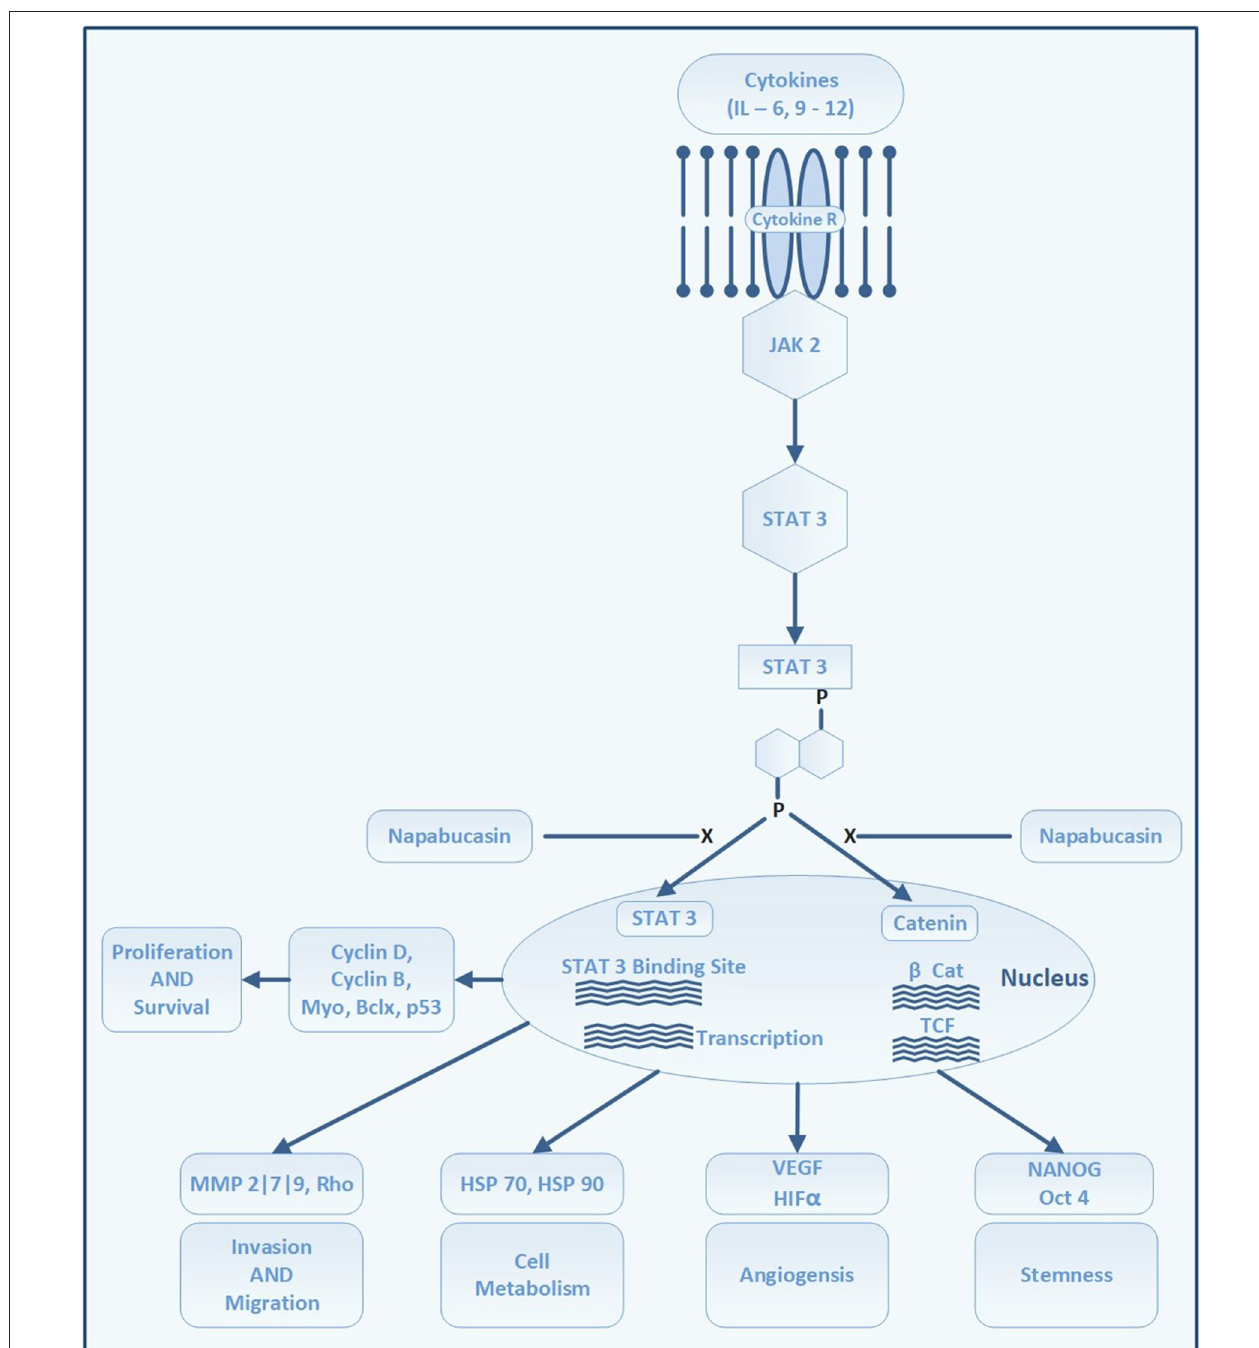
FIGURE 5 | STAT 3 signaling pathway and site of action of napabucasin. Attachment of cytokines to its receptors activates Janus kinases which in turn phosphorylates STAT 3. The phosphorylation of STAT 3 leads to dimerization and activation of STAT 3. STAT 3 enters the nuclei to bind at STAT 3 binding sites on DNA which triggers transcription of several proteins which regulate cell proliferation, survival, angiogenesis, invasion and migration. Through Beta-catenin pathway STAT 3 induces genes responsible to trigger the formation and maintenance of stem cells.